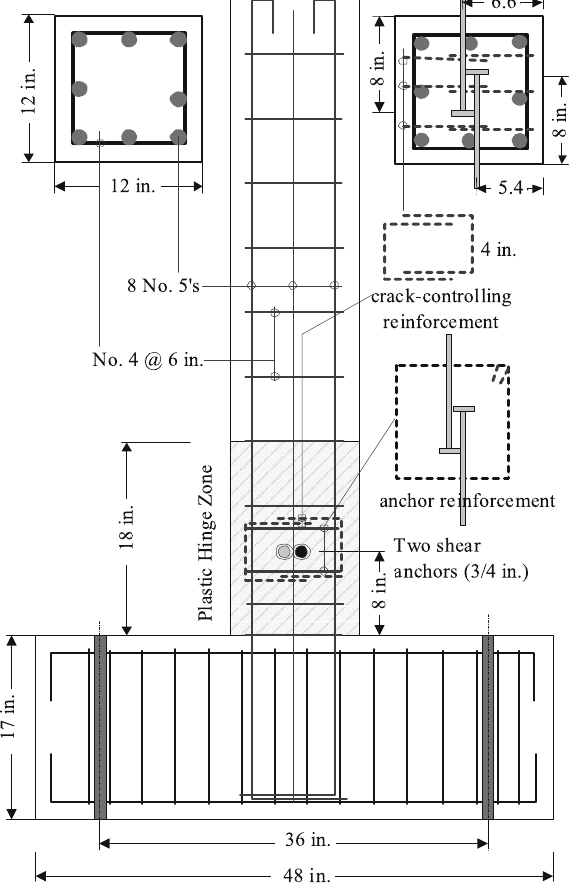
Fig. 3 Dimension and reinforcement of shear sepcimens (1 in. = 25.4